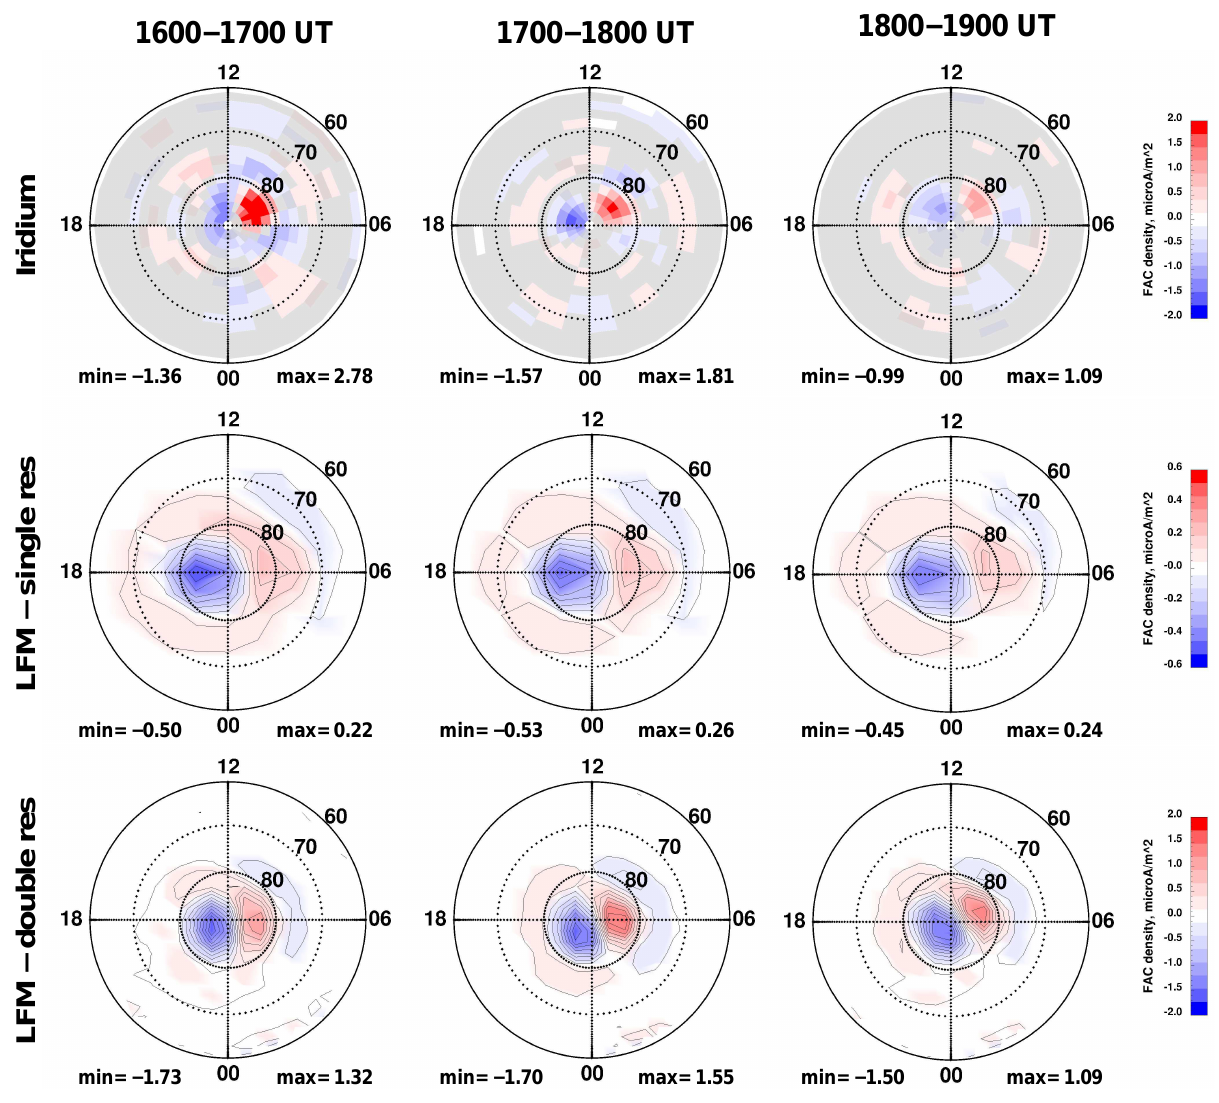
Fig. 2. One-hour average values of the Iridium (1st panel), single resolution LFM model (2nd panel), and double resolution LFM model (3rd panel) ionospheric field aligned current densities for the indicated hours during 16 July 2000. In Iridium plots, cells where the signal is within two standard deviations of zero are shaded gray.